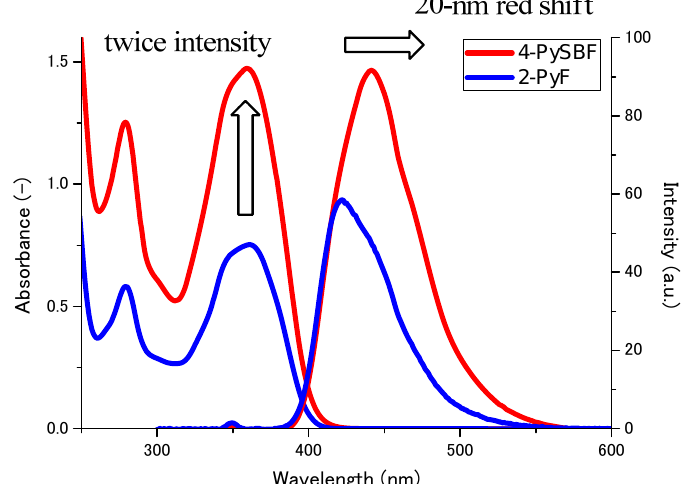
Figure 1. Absorption and emission spectra of 2-PyF and 4-PySBF in CH = 360 nm. λ ex